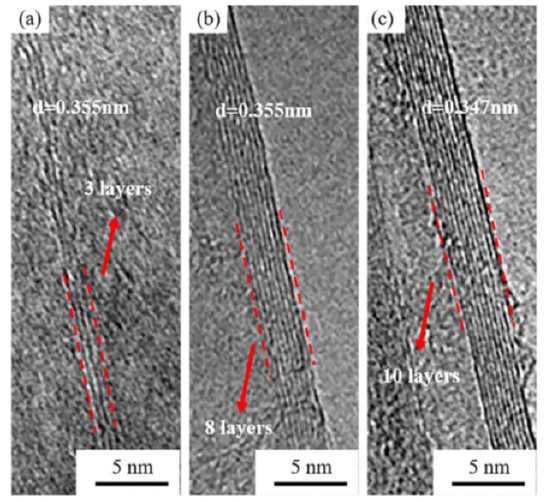
Figure 27. HRTEM images of FLG for laser energy: ( a ) 0.1 J, ( b ) 0.2 J, and ( c ) 0.3 J. [32]